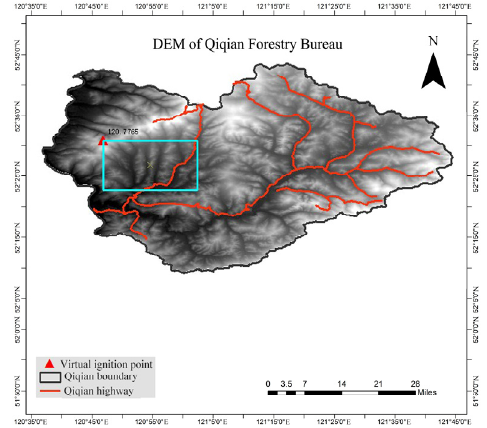
Figure 3. DEM of Qiqian Forestry Bureau.